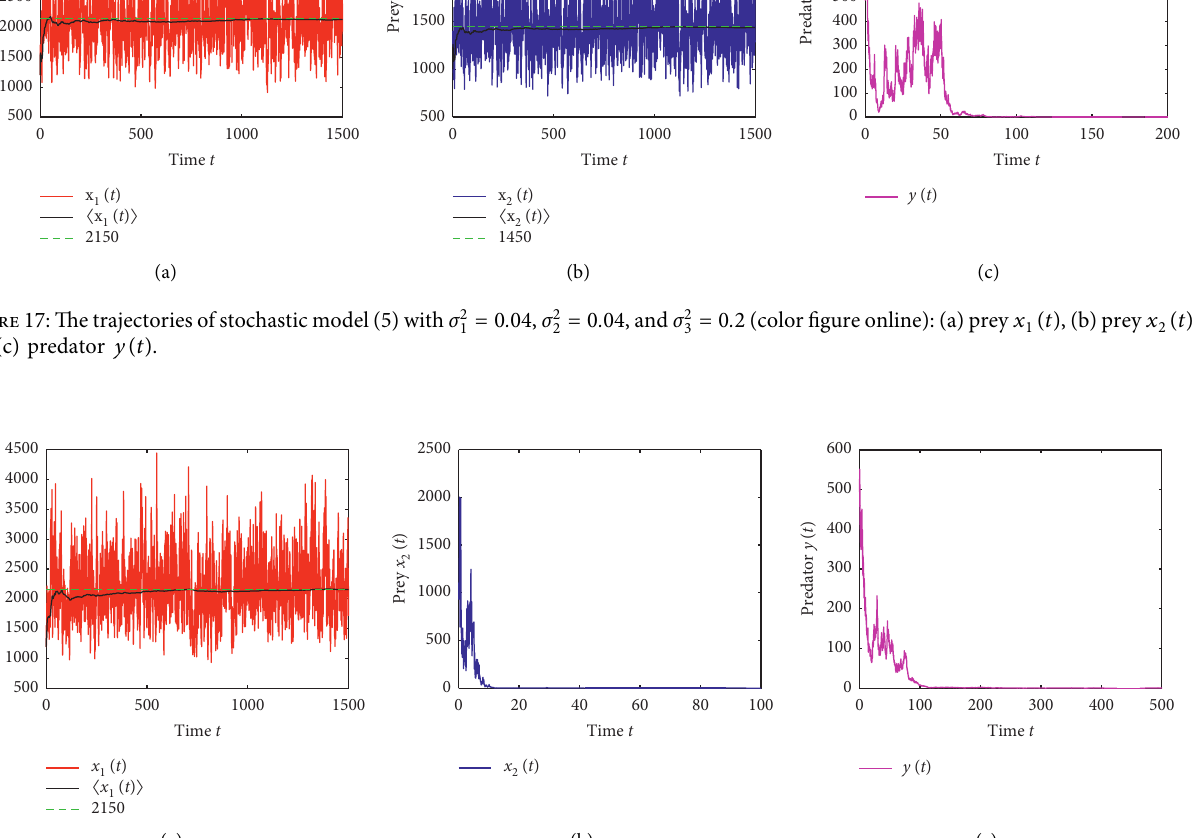
� 0 . 04, σ 2 � 1 . 24, and σ 2 � 0 . 03 (color figure online): (a) prey x 1 2 3